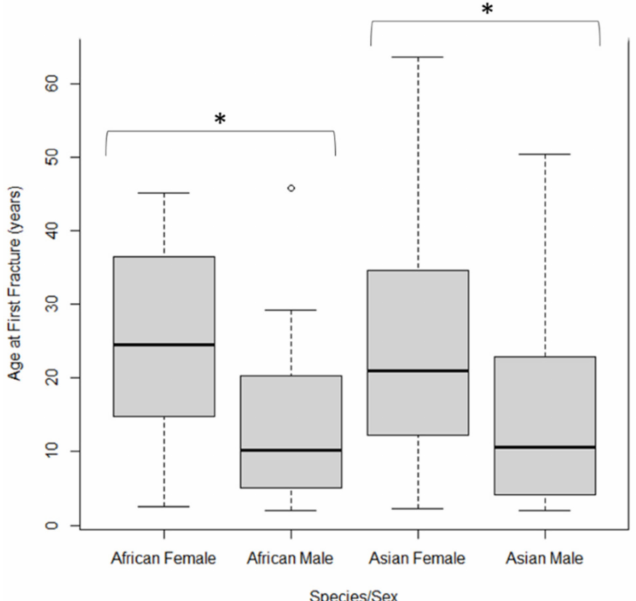
Figure 1. Age (years) at first tusk fracture by species and sex. Asterisk (*) note values of pairings are significantly